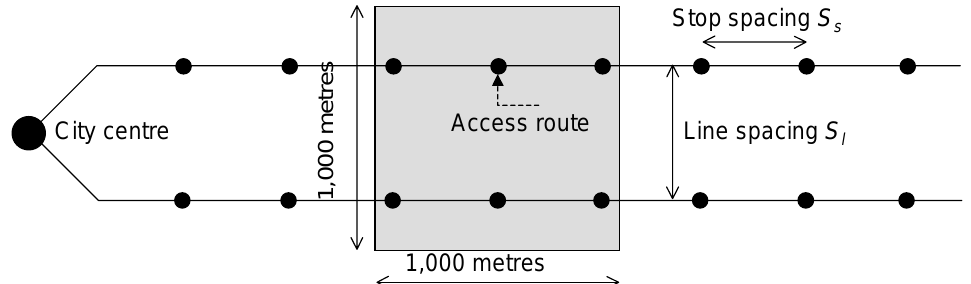
Figure 3. Study area and lay out of the public transport